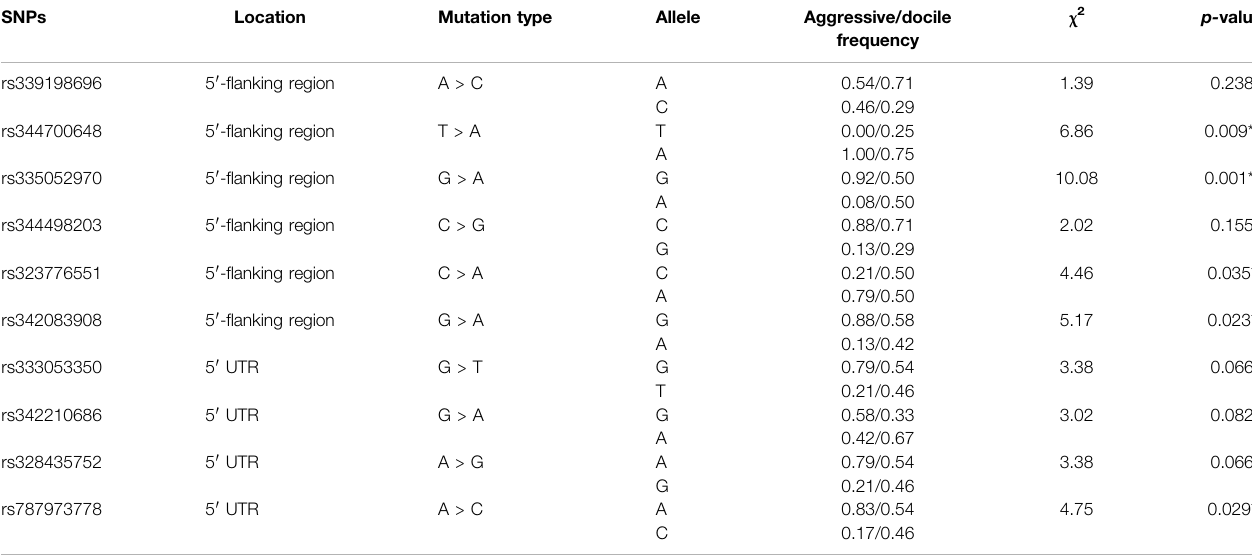
TABLE 2 | Allele frequencies of single-nucleotide polymorphisms (SNPs) in the porcine ARHGAP24 gene.